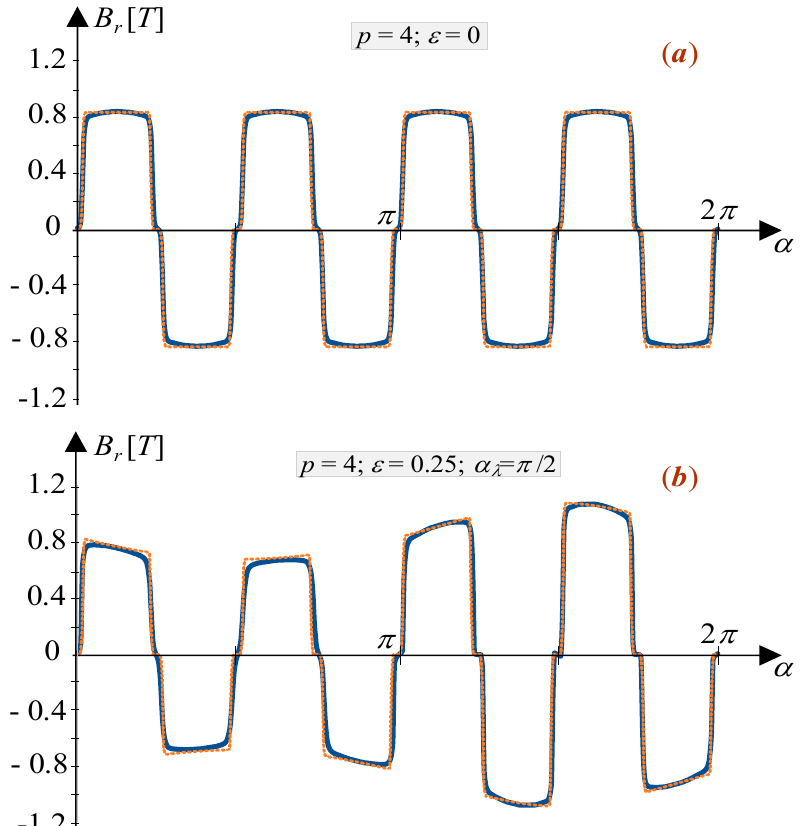
Figure 8. Radial uniform magnetization. Air gap flux-density due to rotor magnets without ( a ) or with ( b ) static eccentricity ( ε = 0.25). The position assumed for the rotor is ϑ = π / 8. Theoretical result ( brown line ); FEM results ( blue line ).